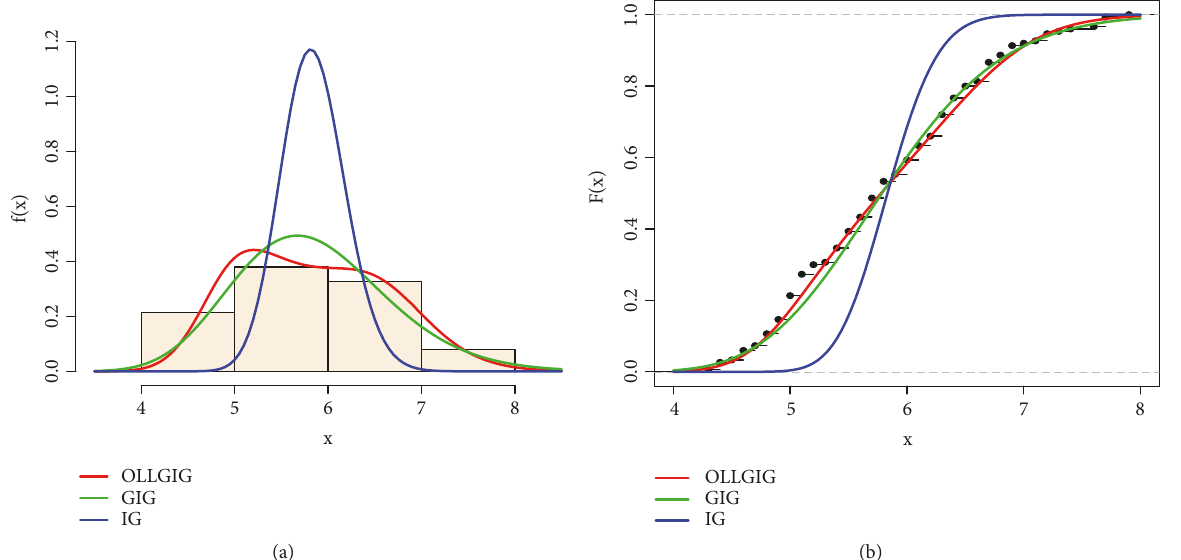
Figure 5: (a) Estimated densities of the OLLGIG, GIG, and IG models for iris data. (b) Estimated cumulative functions of the OLLGIG, GIG, and IG models and the empirical cdf for iris data.